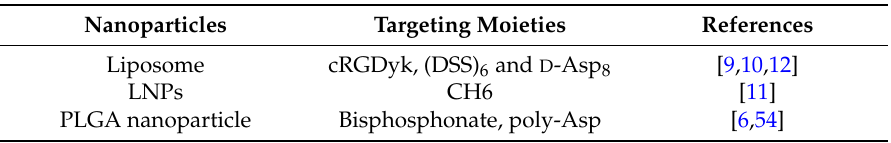
Table 2. Examples of nanoparticles used in targeted delivery systems for molecular therapy in skeletal